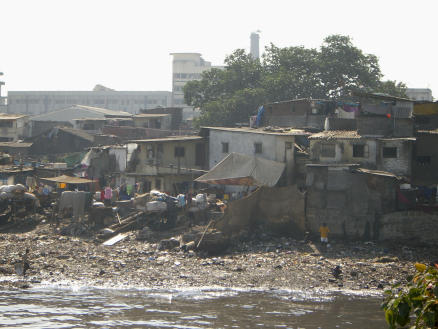
A Jhopadpatti in Mumbai, IndiaThere are 6.7 million slum dwellers among Mumbai's 12 million residents. In the Ganesh Murthy Nagar slum in the Colaba district, one resident noted, “We had one small, smelly toilet for a population of 10 000. Women suffered the most because they had to relieve themselves in the open, and could do so only in the early mornings or after dark” [43]. There are regular outbreaks of diarrheal diseases, leptospirosis, malaria, and dengue in Mumbai's slums [4]. Photo by Lee Riley.